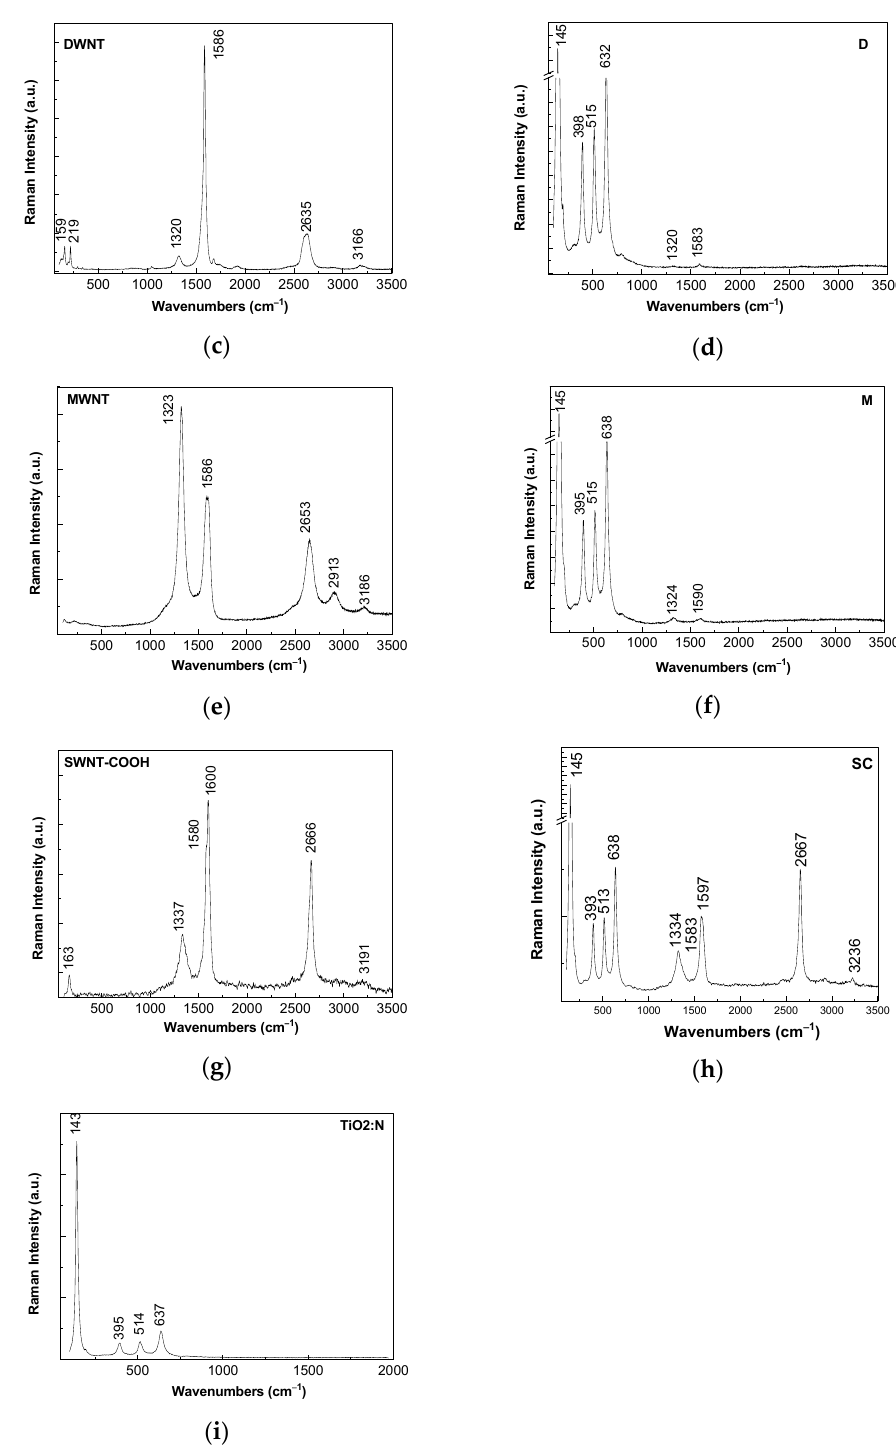
Figure 5. Raman spectra of the samples of SWNTs ( a ), TiO 2 :N/SWNTs (S2 sample) ( b ), DWNTs ( c ), TiO 2 :N/DWNTs (D sample; ( d )), MWNTs ( e ), TiO 2 :N/MWNTs (M sample; ( f )), SWNTs-COOH ( g ), TiO 2 :N/SWNTs-COOH (SC sample; ( h )), and TiO 2 :N ( i ), recorded at the excitation wavelength of 633 nm.